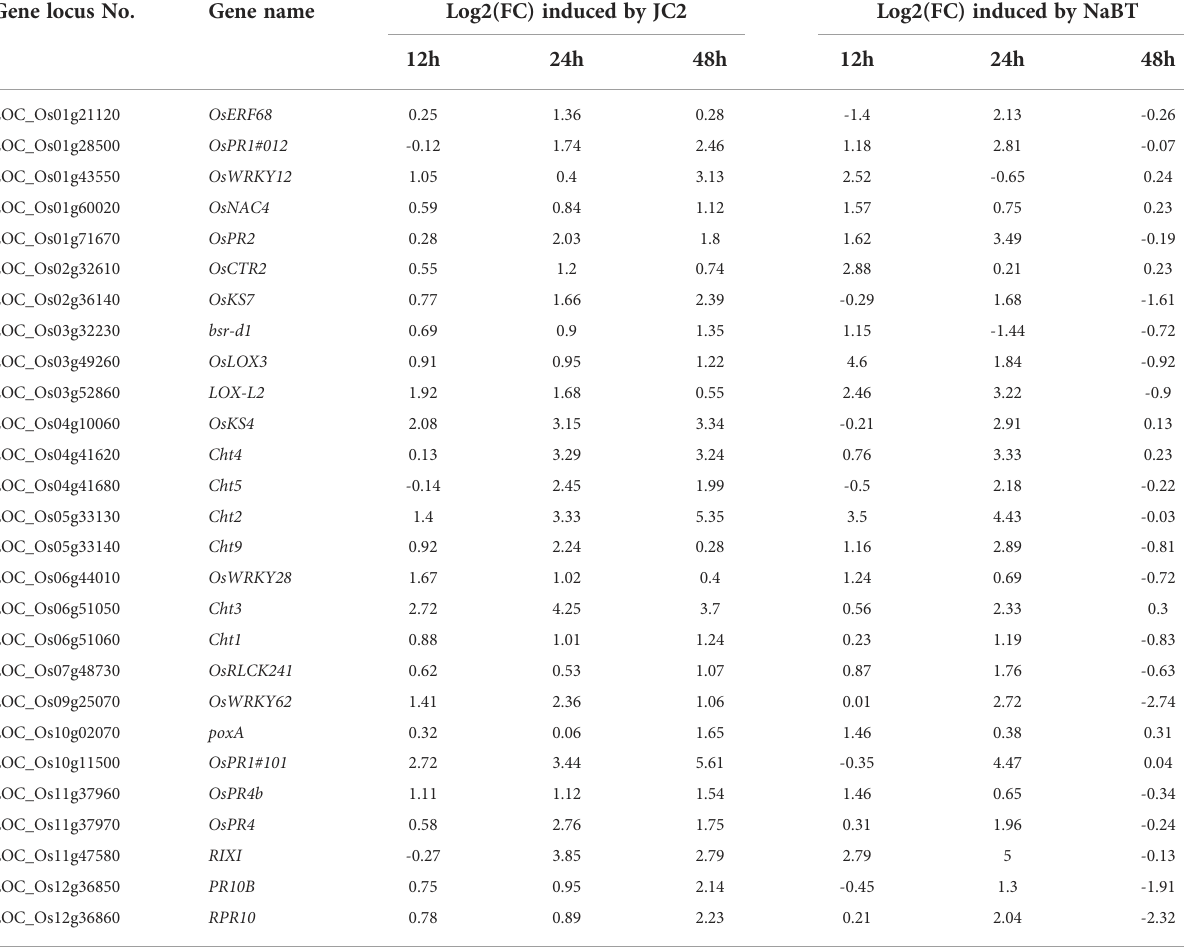
TABLE 1 List of 27 defense-related genes up-regulated by inoculation of M. oryzae (JC2) and NaBT treatment. Gene locus